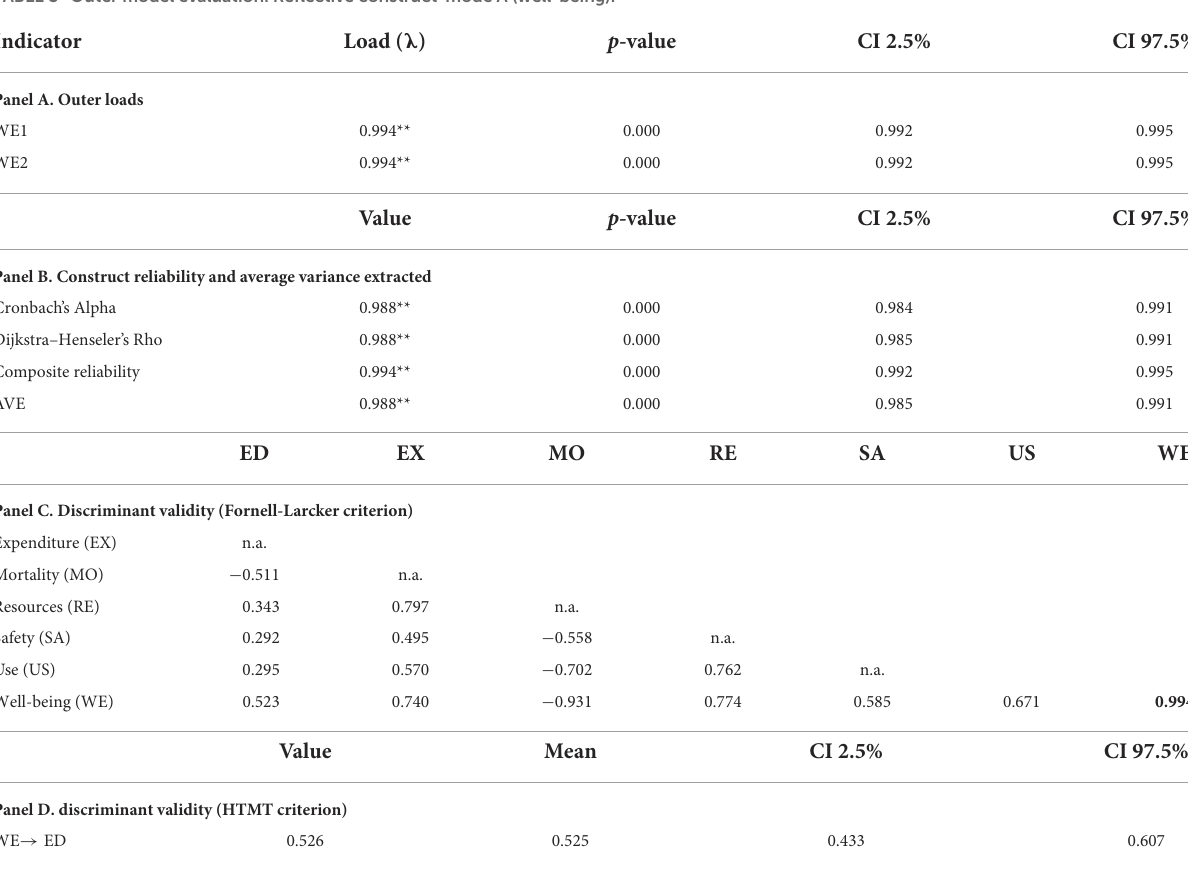
TABLE 3 Outer model evaluation. Reflective construct-mode A